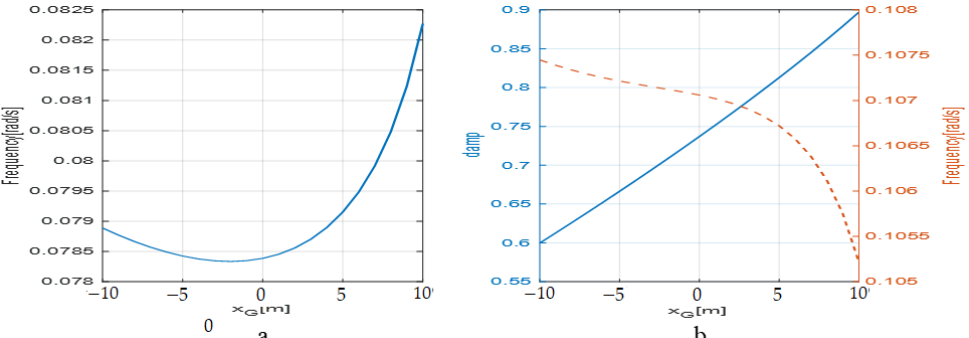
Figure 9. Curve of Influence of Axial Mass Center Perturbation on Pitching Channel Motion Mode: (a) Bode plot of the pitching channel with axial location perturbation of the mass center, (b) amplitude frequency and phase frequency deviation curves of the pitching channel with axial location perturbation of the mass center